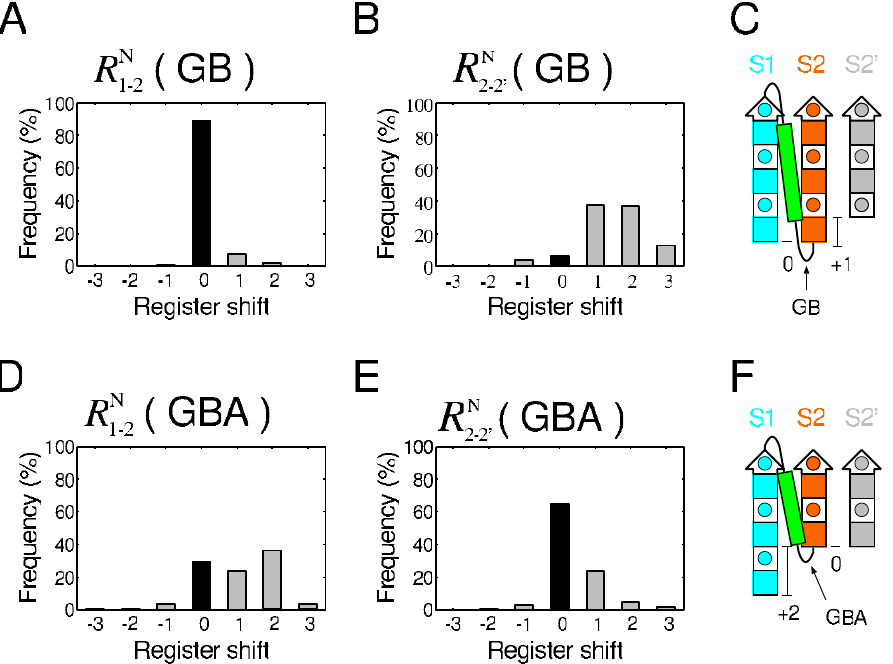
Fig 3. The distribution of register shifts of the two most frequently observed loop types with anti-parallel orientation in αβ -units in the dataset. (A) Distribution of the register shift of R N (C) Schematic structure of a βαβ -motif with the most frequent register shift of R N Distribution of the register shift of R N the most frequent register shift of R N a single amino acid residue with side chain located on the proximal side, and the colored filled square represents a residue with a side chain located on the opposite